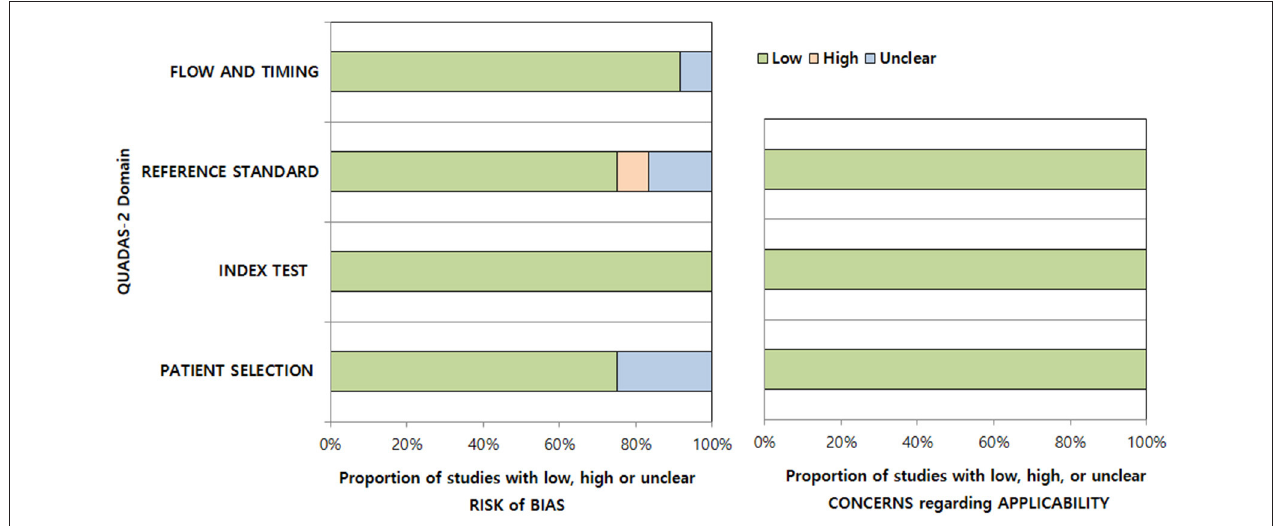
FIGURE 3 | Quality assessment of the included studies according to the Quality Assessment of Diagnostic Accuracy Studies-2 (QUADAS-2)